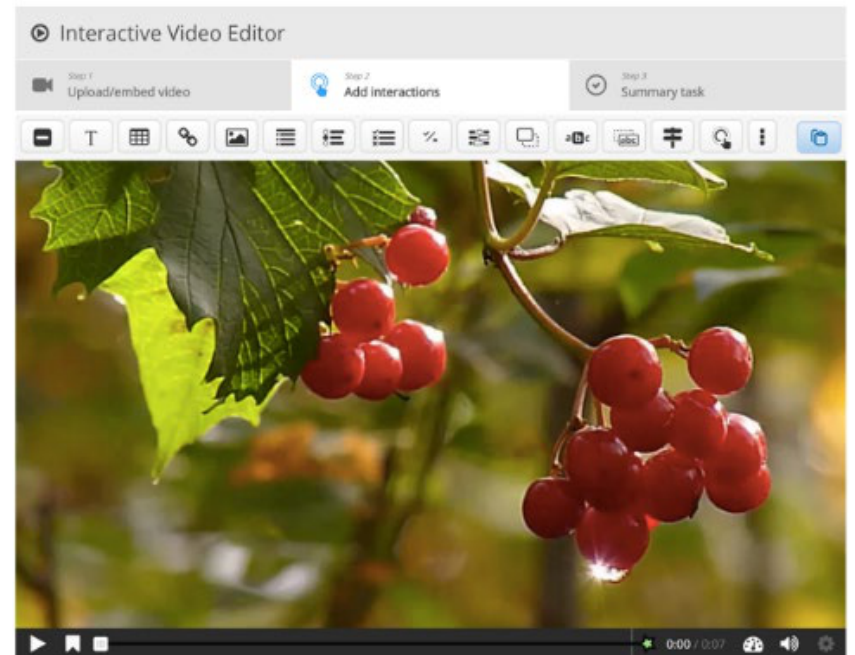
Figure 2 Example of interactive video tutorial